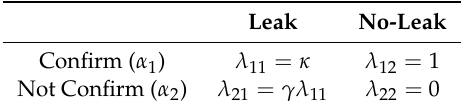
Table 3. Overview of the cost functions applied in this example. The cost function can be interpreted as having no cost to doing the correct decision. Confirming a no-leak has some operational cost, e.g., a ship must mobilize and search/confirm that there is no leakage. Confirm a leakage has a cost of κ times the operational cost. The cost of not confirming a true leakage is gamma times the cost of confirming a leakage. We assume there is no cost with not looking for a leak when there is no leakage.